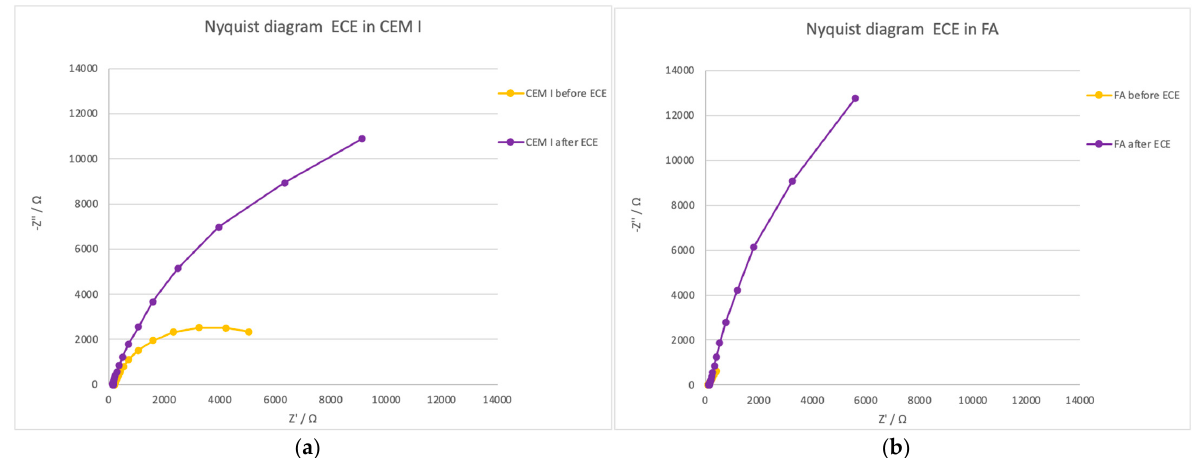
Figure 10. Corrosion potential and corrosion rate (E corr and I corr ) monitoring.